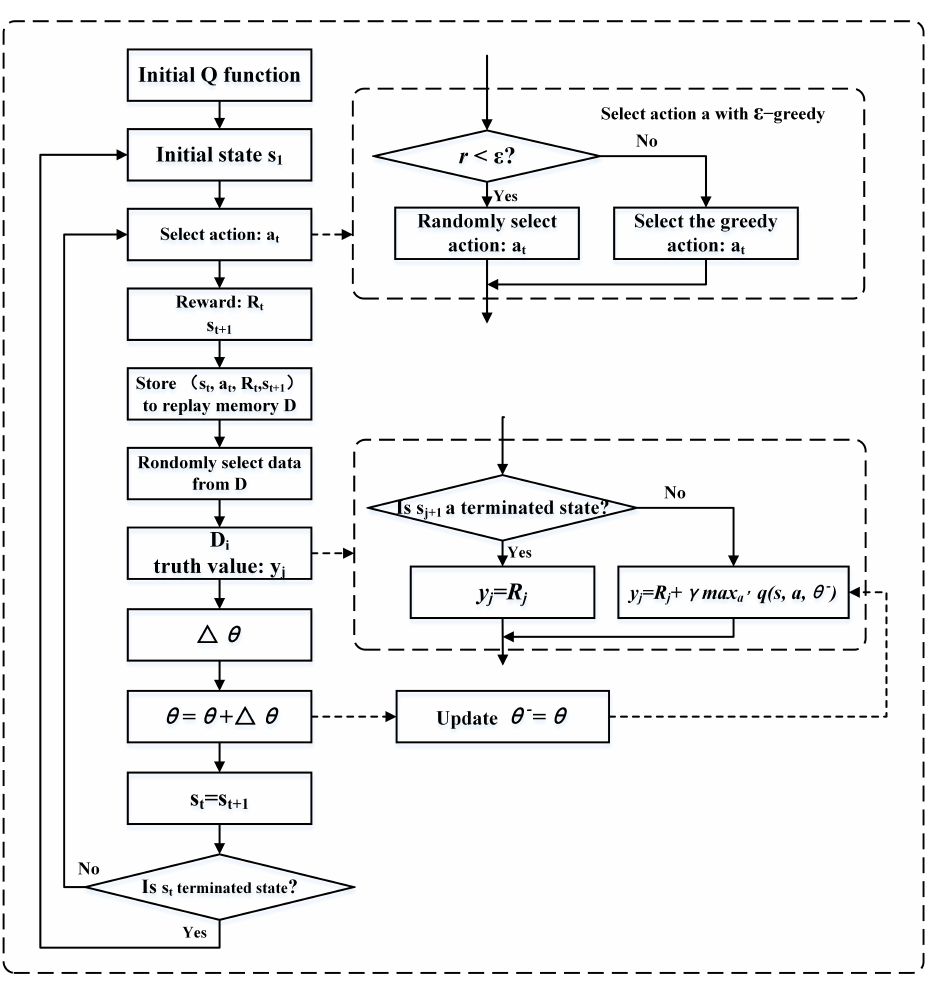
Figure 8. The training process of reinforcement